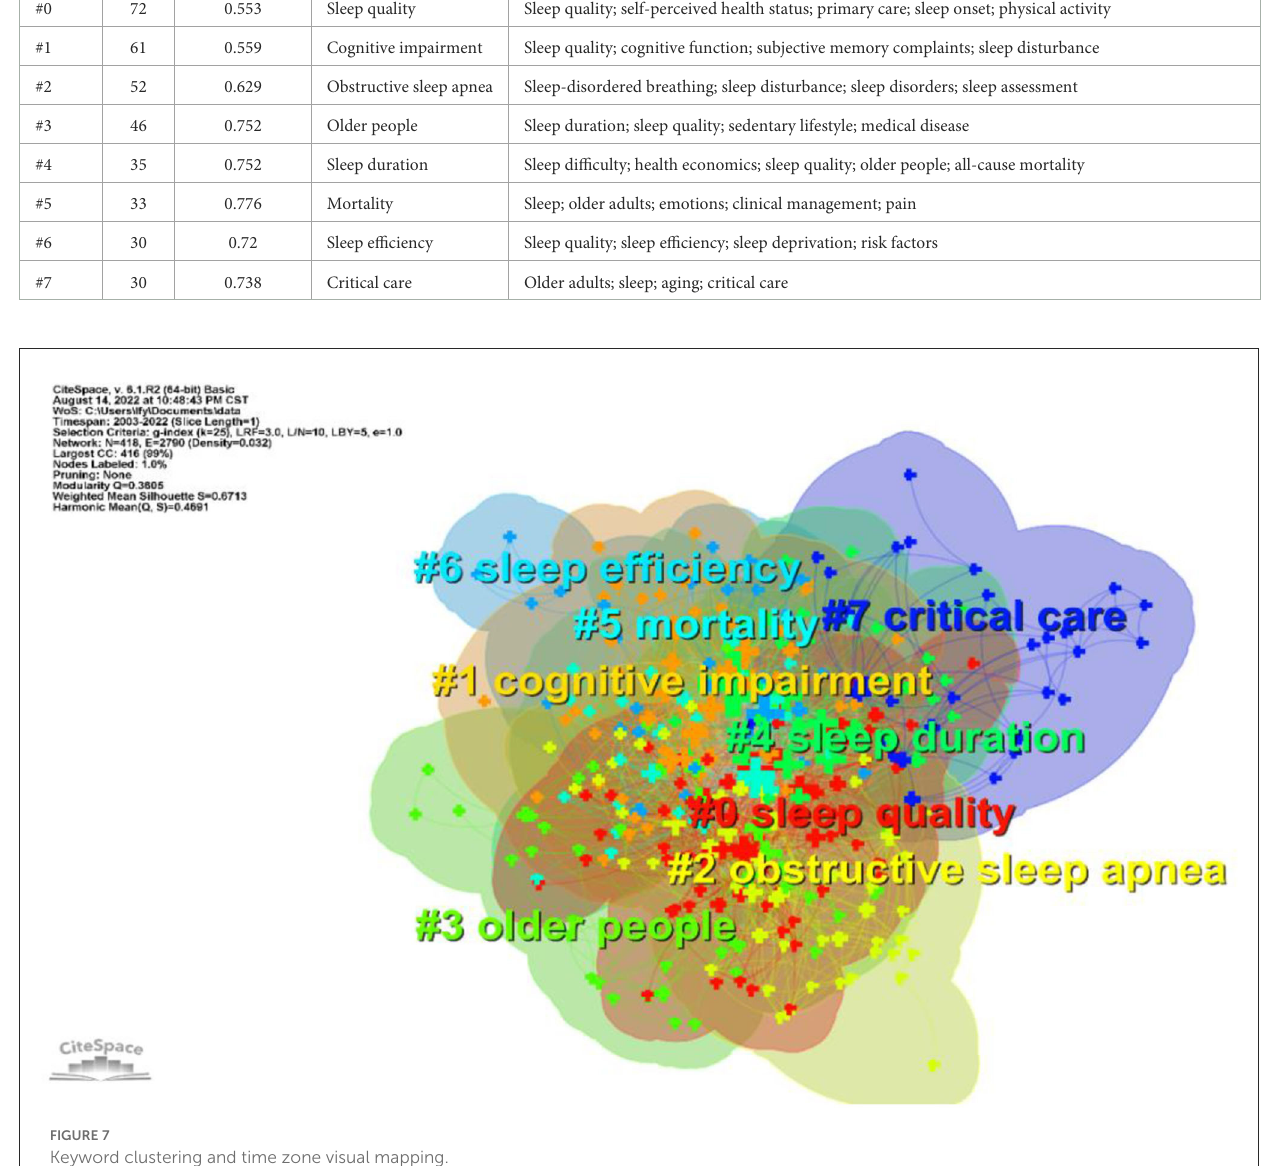
learning and communication. This collaboration is conducive to in- depth advances in this field and has a positive impact on the future direction of its